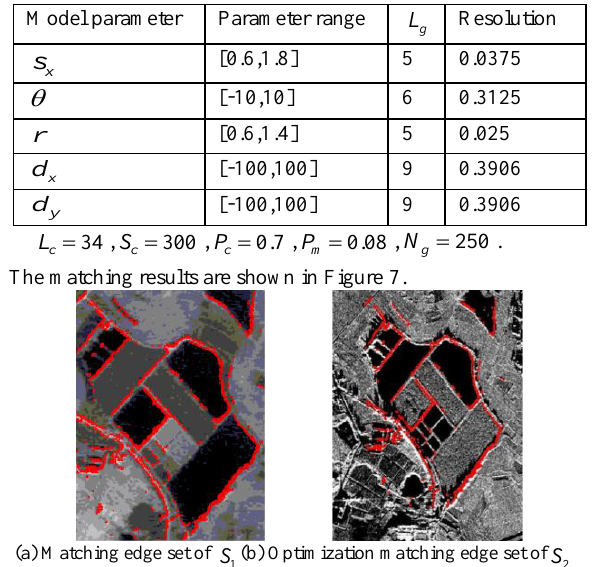
Figure 7.Matching